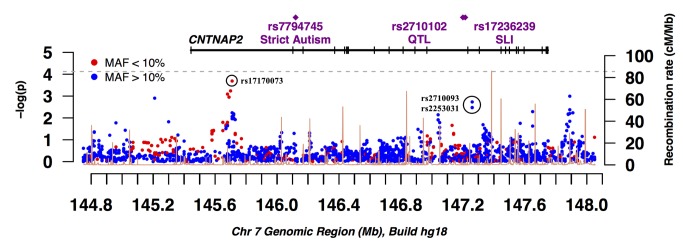
A plot of -log10
p across CNTNAP2 from family-based association test (TDT) results on 186 multiplex families.The physical position within the CNTNAP2 locus in megabases (Mb) and the -log10
p-values are shown on the x and y-axis, respectively. SNPs with minor allele frequency (MAF) <10% and those with MAF ≥10% are shown as red and blue filled circles, respectively. A horizontal line represents the CNTNAP2 gene, with vertical hash marks indicating exons, and locations of individual SNPs showing region-wide statistical significance in prior studies are indicated. The recombination rate in cM/Mb (right y-axis) is shown in orange. The horizontal grey dashed line represents the -log10
p-value for region-wide significance level (7.5 x 10-5).